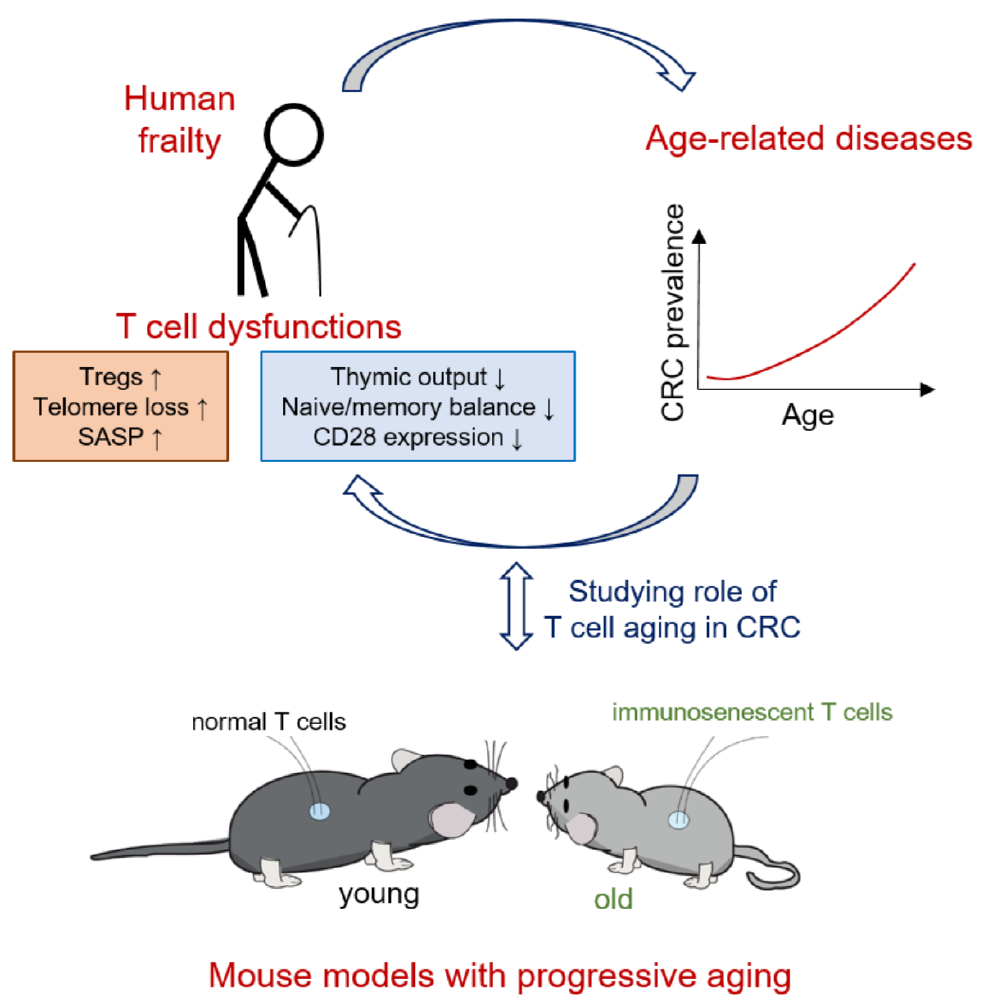
Figure 2. Aging affects the organism as a whole, inducing T cell dysfunctions as well. Increased ( ↑ ) numbers of Tregs, secretory-associated senescence phenotype (SASP) and telomere loss, as well as decreased ( ↓ ) thymic output, naïve/memory balance and CD28 co-stimulatory expression are specific signs of immunoaging. This can lead to the development of CRC, which is predominant in elderly. Using mouse models with progressive aging might elucidate the functional role of T cell aging in individuals with colorectal cancer.